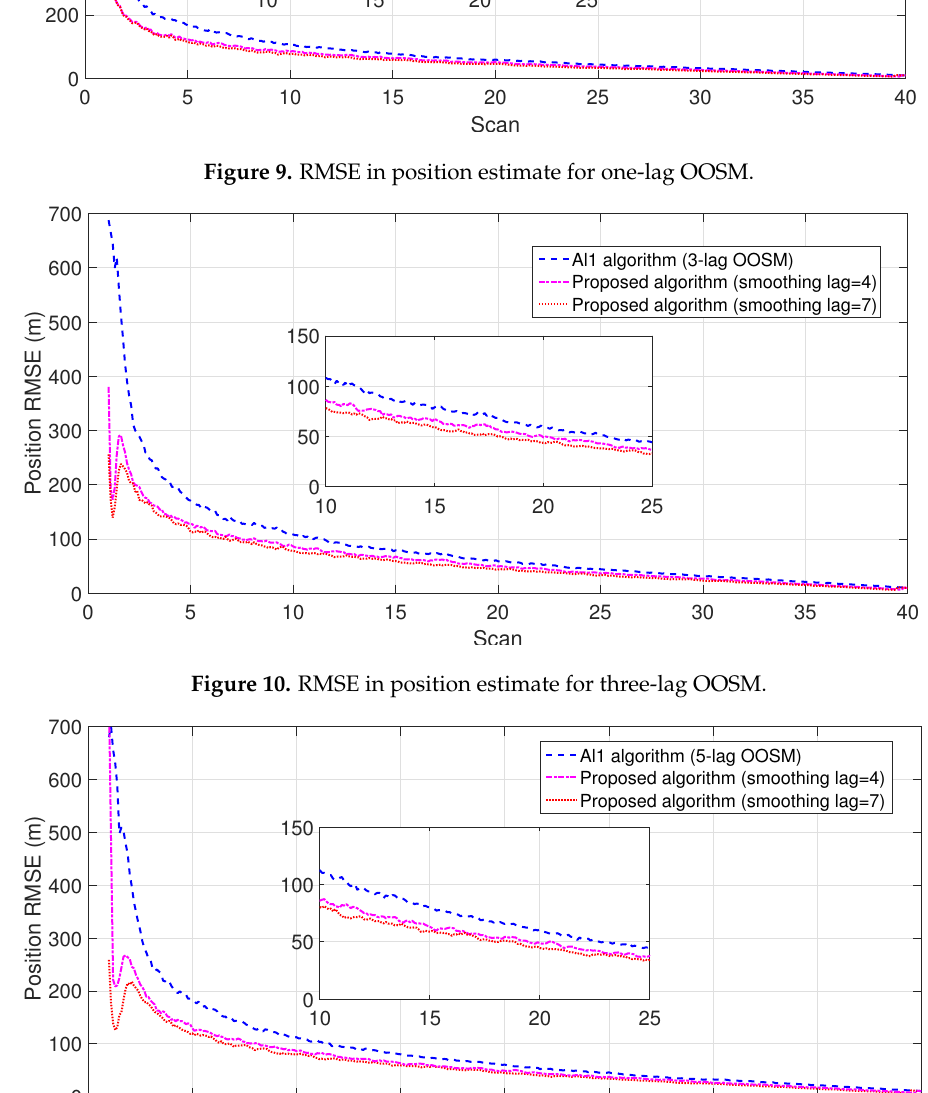
Figure 11. RMSE in position estimate for five-lag